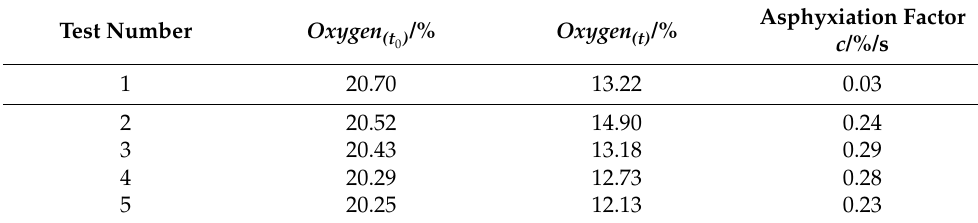
Table 5. Asphyxiation efficiency under different test